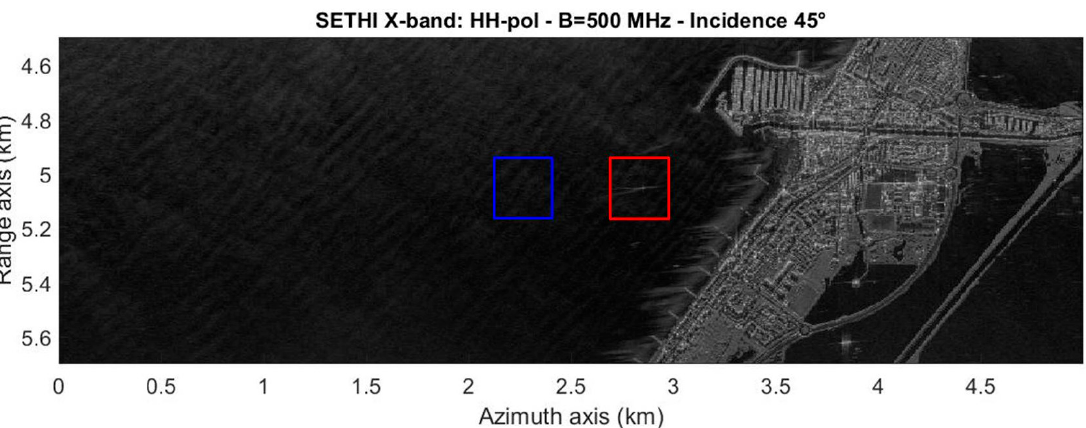
Figure 1. Illustration of an X-band SAR image in the Mediterranean Sea—blue box: target free area, red box: sea surface including a ship.